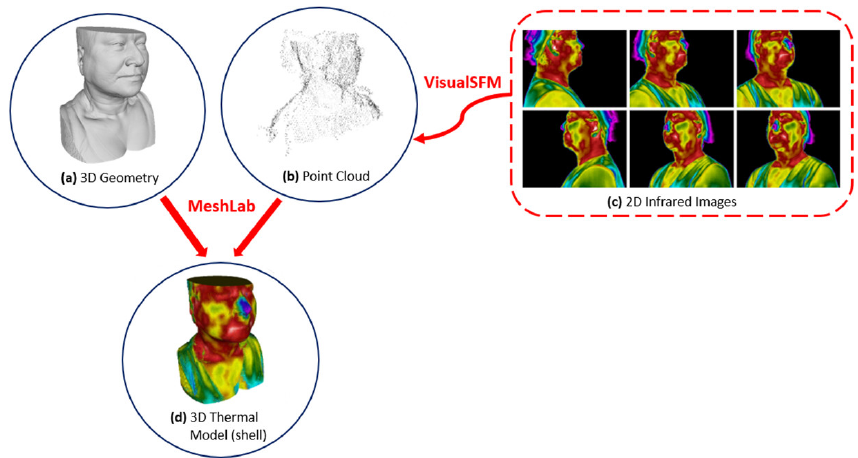
Figure 10. Flowchart showing the fusion and alignment of the imaging modalities: ( a ) 3D shell; ( b ) point cloud; and ( c ) thermal images, allowing the generation of the ( d ) 3D thermal shell.